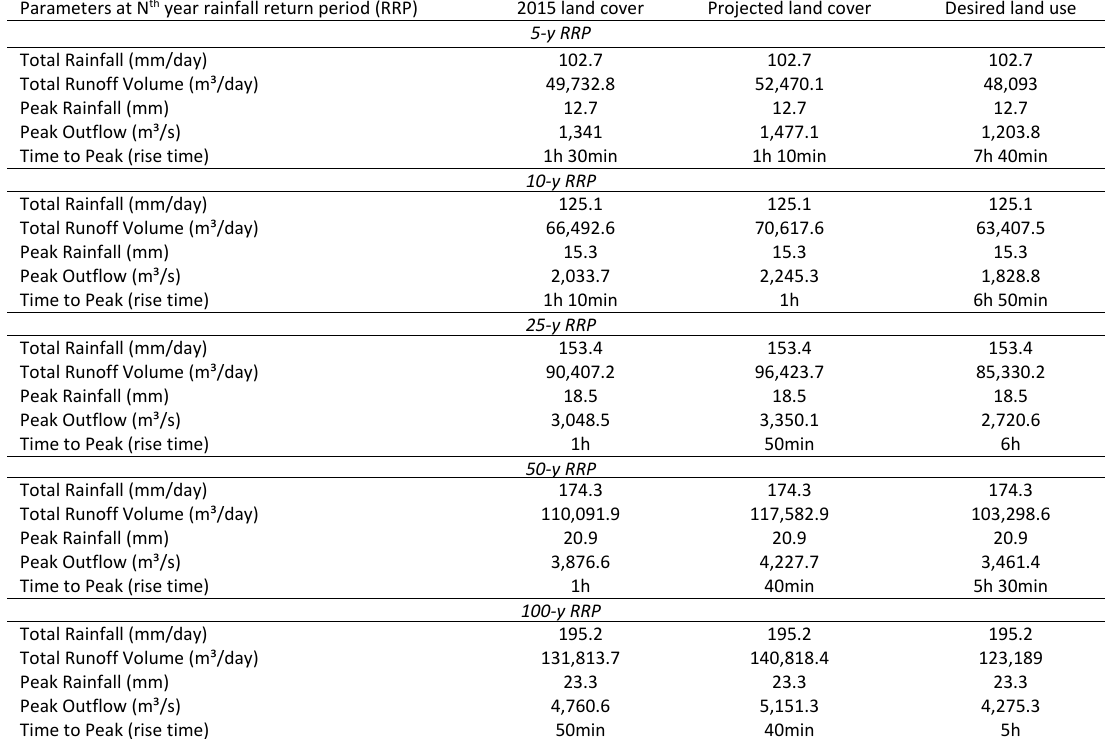
Table 4: Proportion and area of the desired land use Table 5: Result of simulation from different parameters at N th year rainfall return period using HEC-HMS